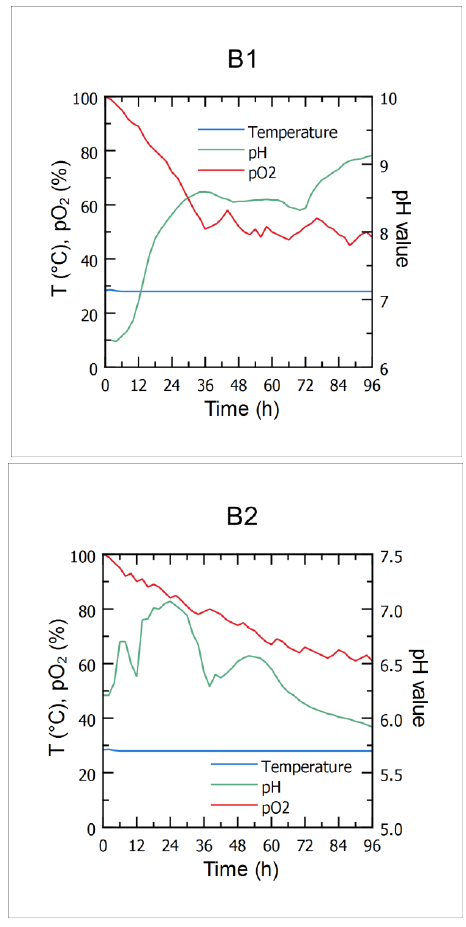
Figure 1. Cultivations of Bacillus sp. BioSol021 in a 16 L bioreactor - cultivation courses in terms of temperature, pH value and DO content using the food industry effluents-based media: B1—cheese whey from dairy industry, B2—winery flotation wastewater.